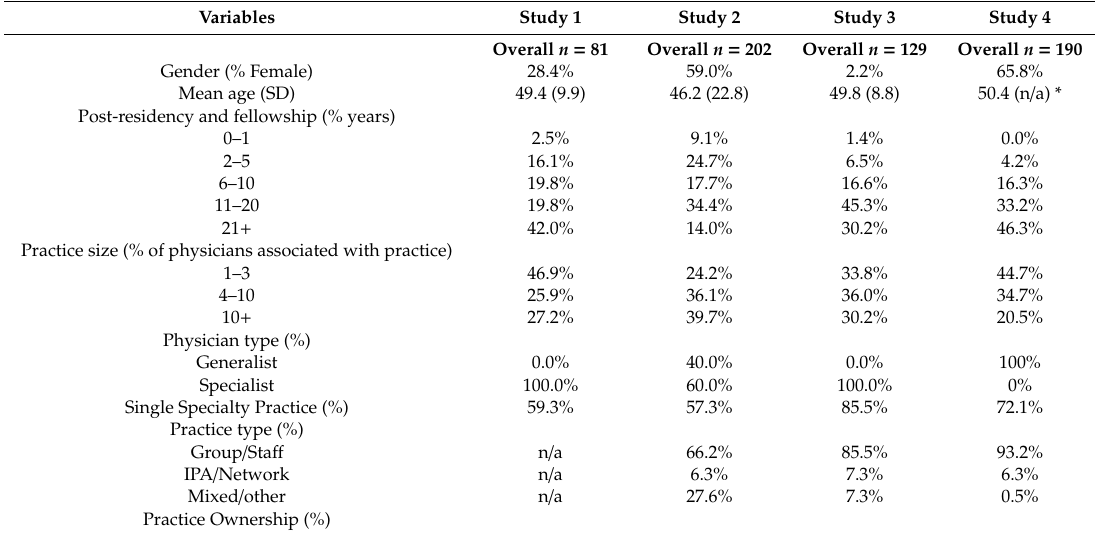
Table 2. Baseline characteristics by